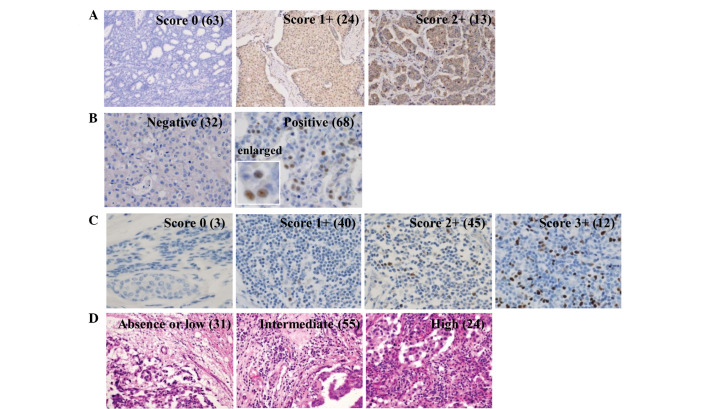
Immunohistochemical forkhead box protein 3 (FOXP3) staining in breast cancer. Representative images of FOXP3 expression in (A) the cytoplasm (magnification, ×100) and (B) the nucleus (magnification, ×400) of tumor cells and (C) the lymphocytic infiltrate (magnification, ×400). (D) Hematoxylin and eosin (H&E) staining intensity of tumor-infiltrating lymphocytes (TILs) (magnification, ×200). The number of specimens in each graded group is indicated in parenthesis. A score of 1+/2+ in (A) or 2+/3+ in (C) was defined as positive for tumor-cytoplasmic FOXP3 or lymphocyte FOXP3 (i.e., high infiltration of FOXP3+ lymphocytes).